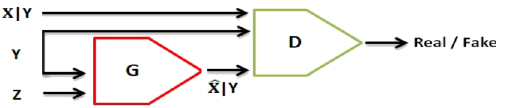
Figure 4. Both G and D are conditioned with the class labels in